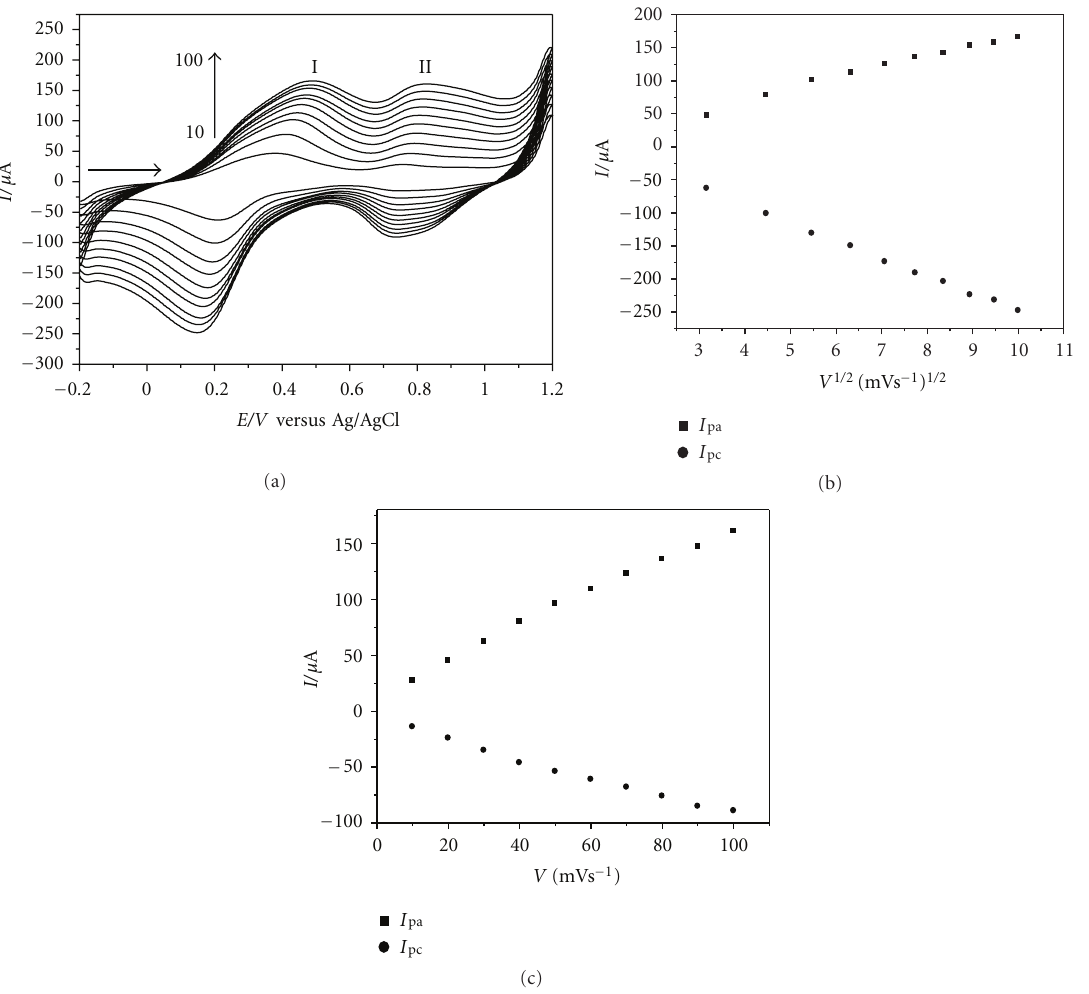
Figure 4: (a) Cyclic voltammogram of CuNPSD for di ff erent scanning rates: 10–100 mVs − 1 (KCl = 1.0mol L − 1 , pH = 7.0). (b) Linear dependence of the anodic and cathodic current intensity with the square root of scan rate (peak I). (c) Linear dependence of the anodic and cathodic current intensity with the scan rate